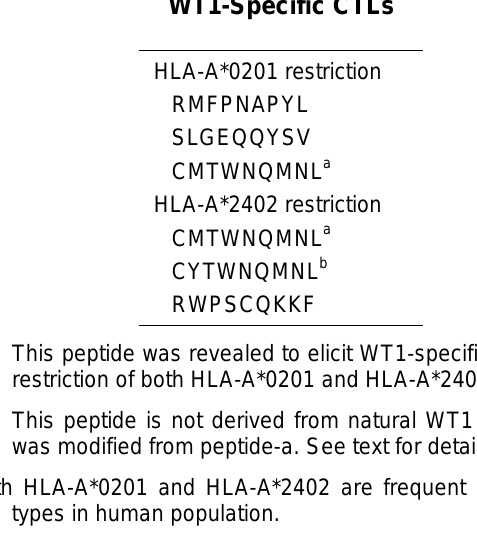
CTL Epitopes that can